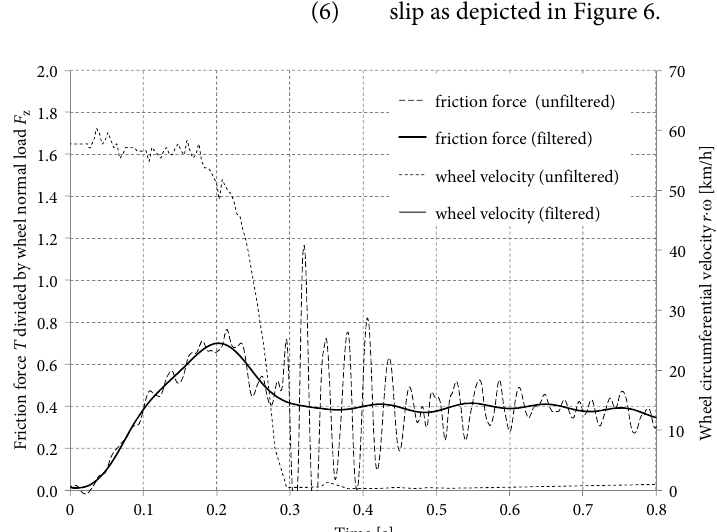
Figure 4. The friction force T divided by the wheel normal load F z and circumferential velocity of the wheel r ⋅w after filtration